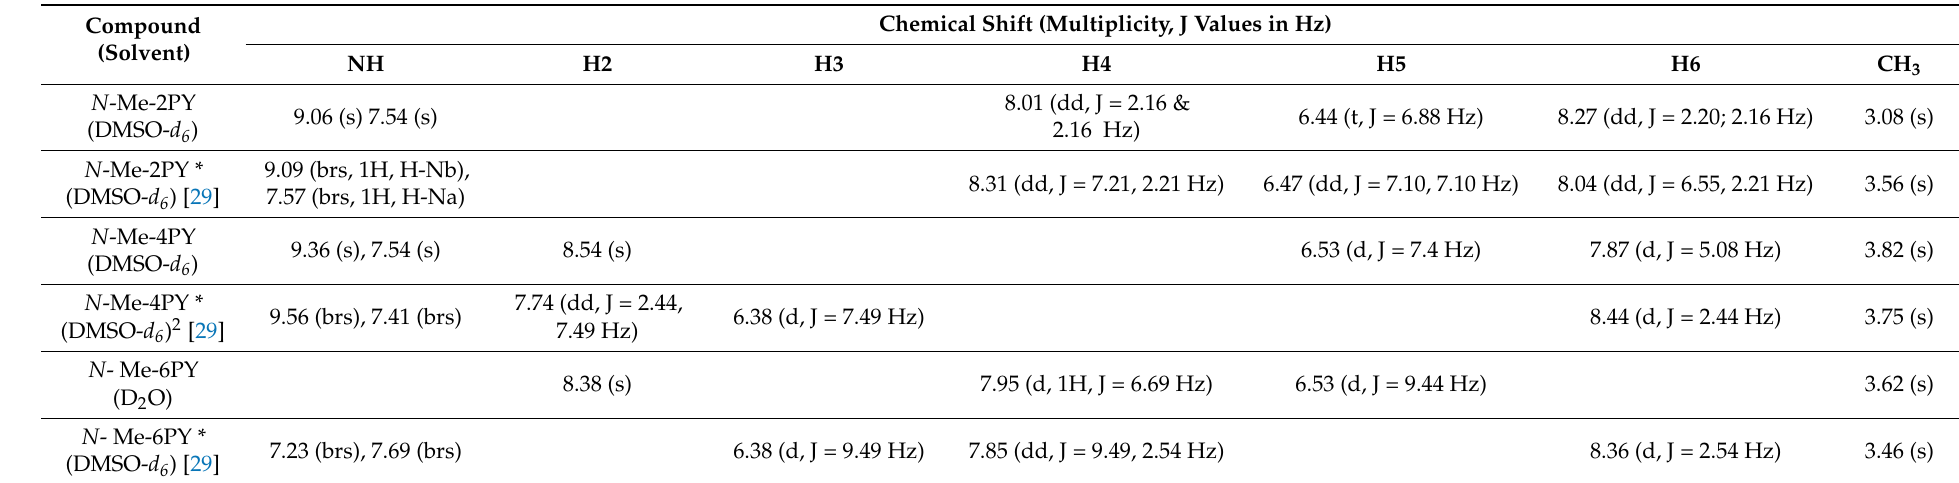
Table 2. Tables of 1 H NMR chemical shift for the methylated